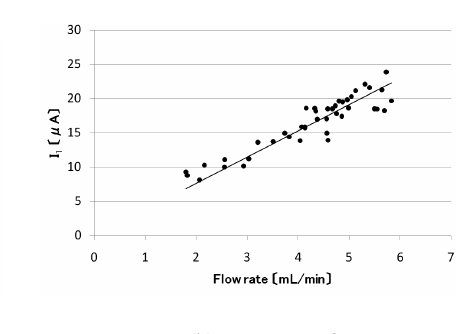
Fig. 12 Pressure load as a function of